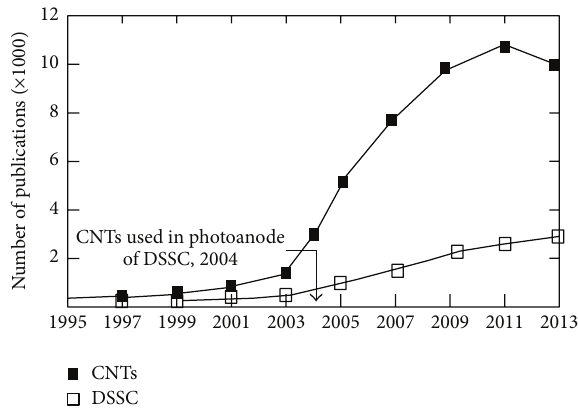
Figure 1: Rise of publications number, concerning nanotubes and DSSCs, with time.